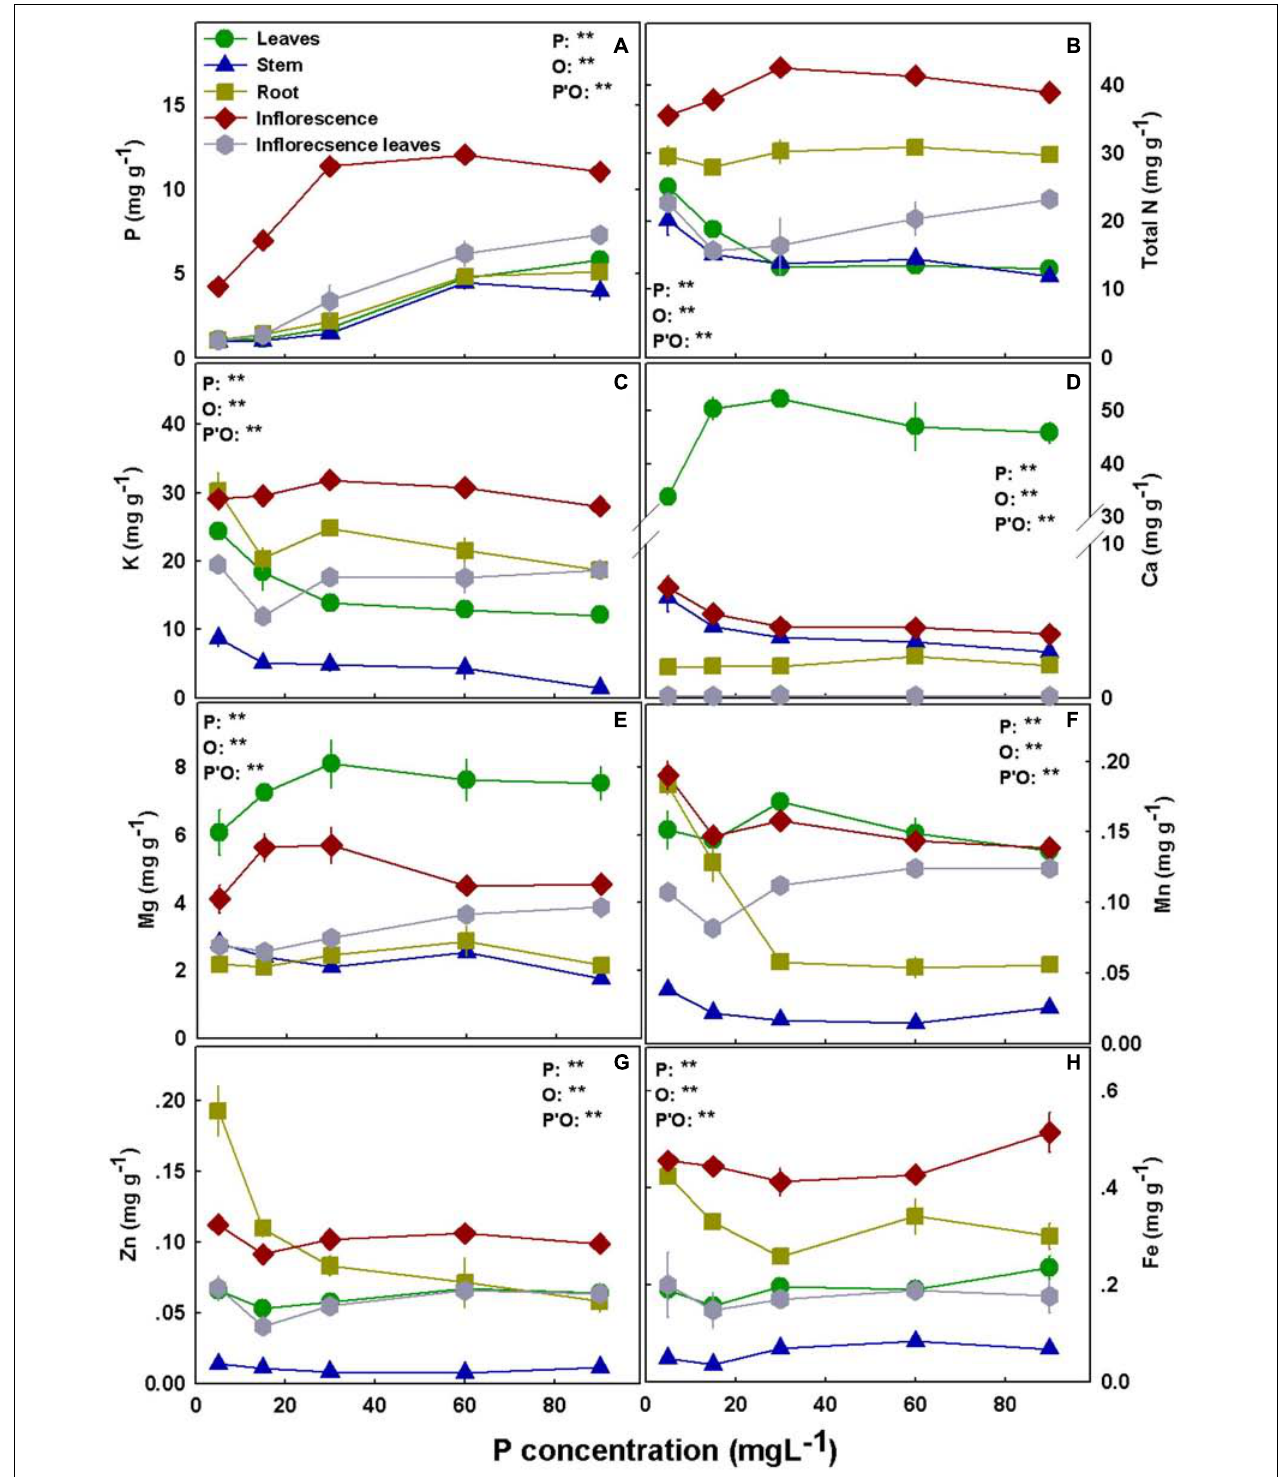
FIGURE 5 | Effect of P supply on nutrient concentrations in leaves, stems, roots, and inflorescences in the medical cannabis cultivar RM. P (A) , N (B) , K (C) , Ca (D) , Mg (E) , Mn (F) , Zn (G) , and Fe (H) . The presented data are averages ± SD ( n = 5); the concentrations are in mg g DW − 1 . Results of two-way ANOVA indicated as ** P < 0.05, F -test; NS, not significant P > 0.05, F -test. In the ANOVA results, P, phosphorus; O, organ; and P*O, the interaction between P and O.